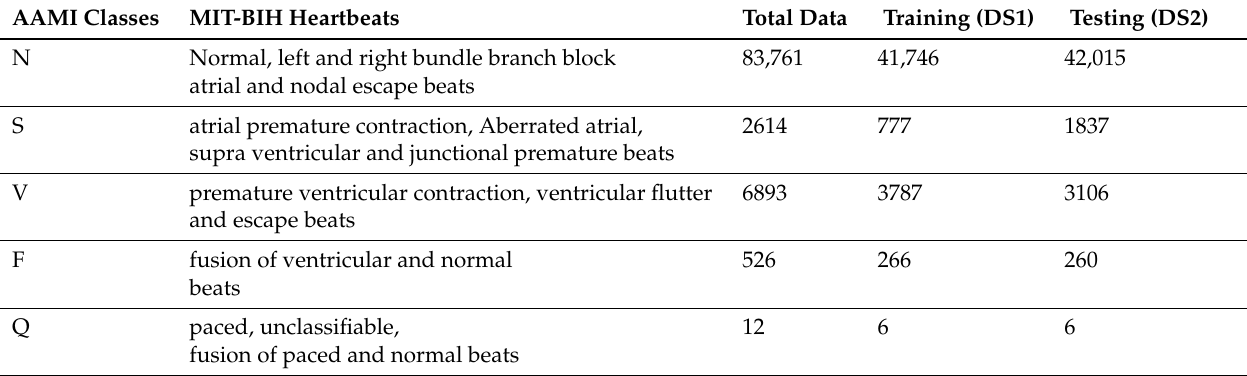
Table 1. Details of the number of beats selected from each group of AAMI